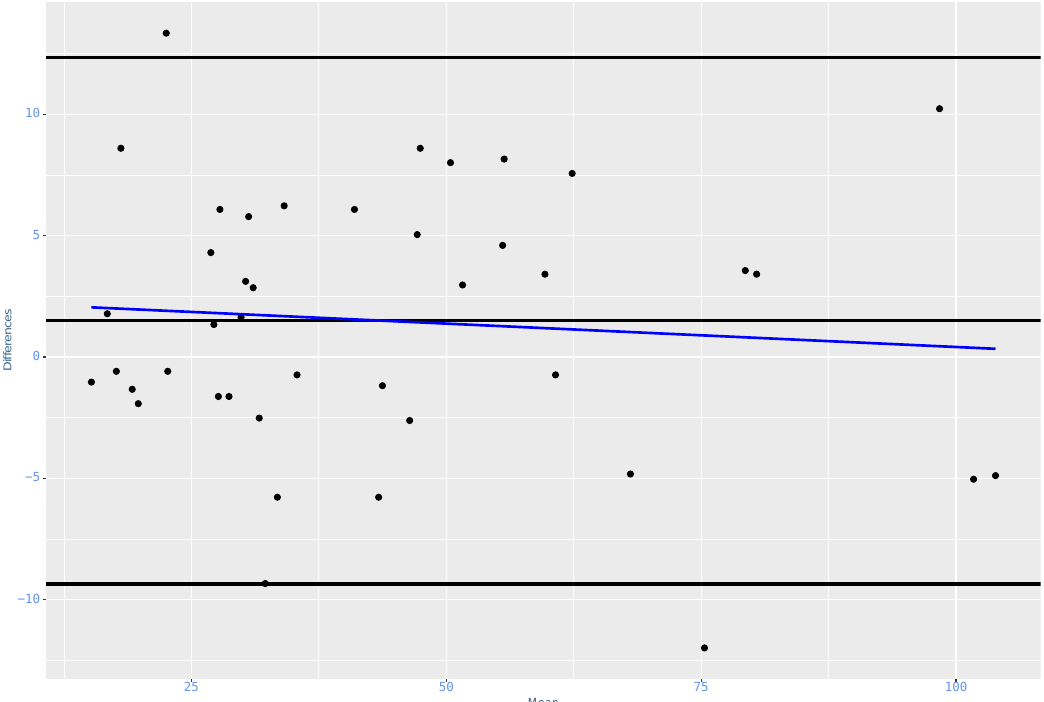
Figure 4. Bland–Altman plot for dynamometry with scapula repositioning. Blue line = regression